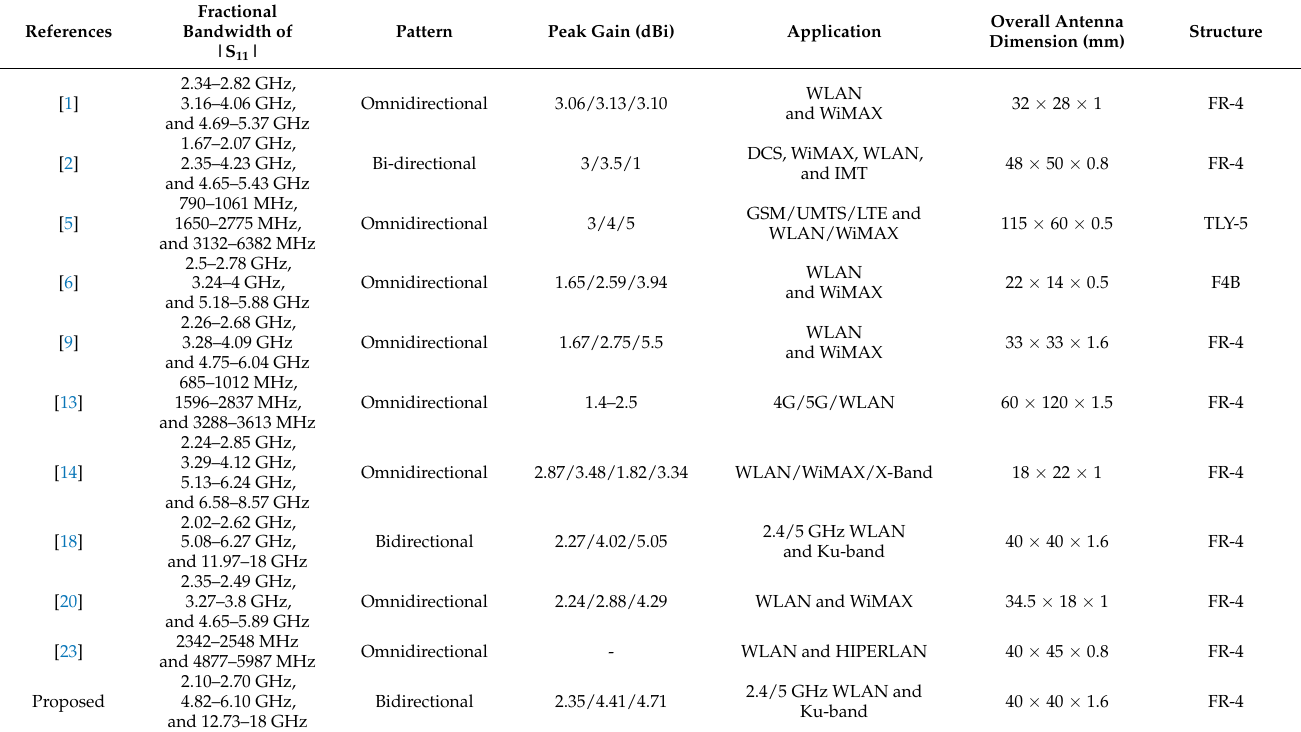
Table 2. Comparison between previous studies and this current